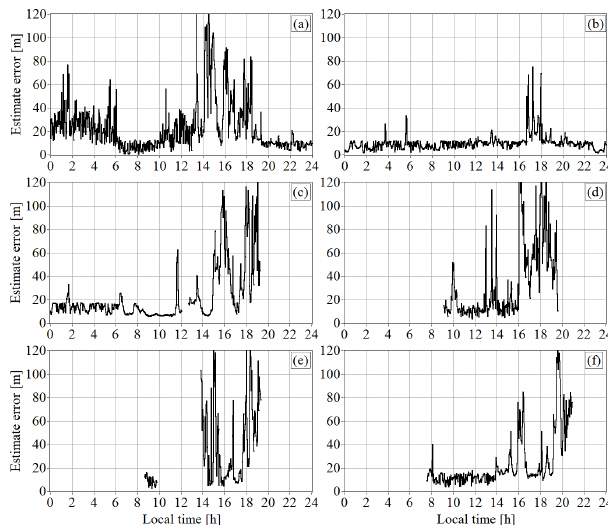
Figure 10. Error of estimation of the mixing layer heights deter- mined from measurements on 20 July (a) , 21 July (b) , 22 July (c) , 23 July (d) , 24 July (e) , and 25 July (f) of 2019.